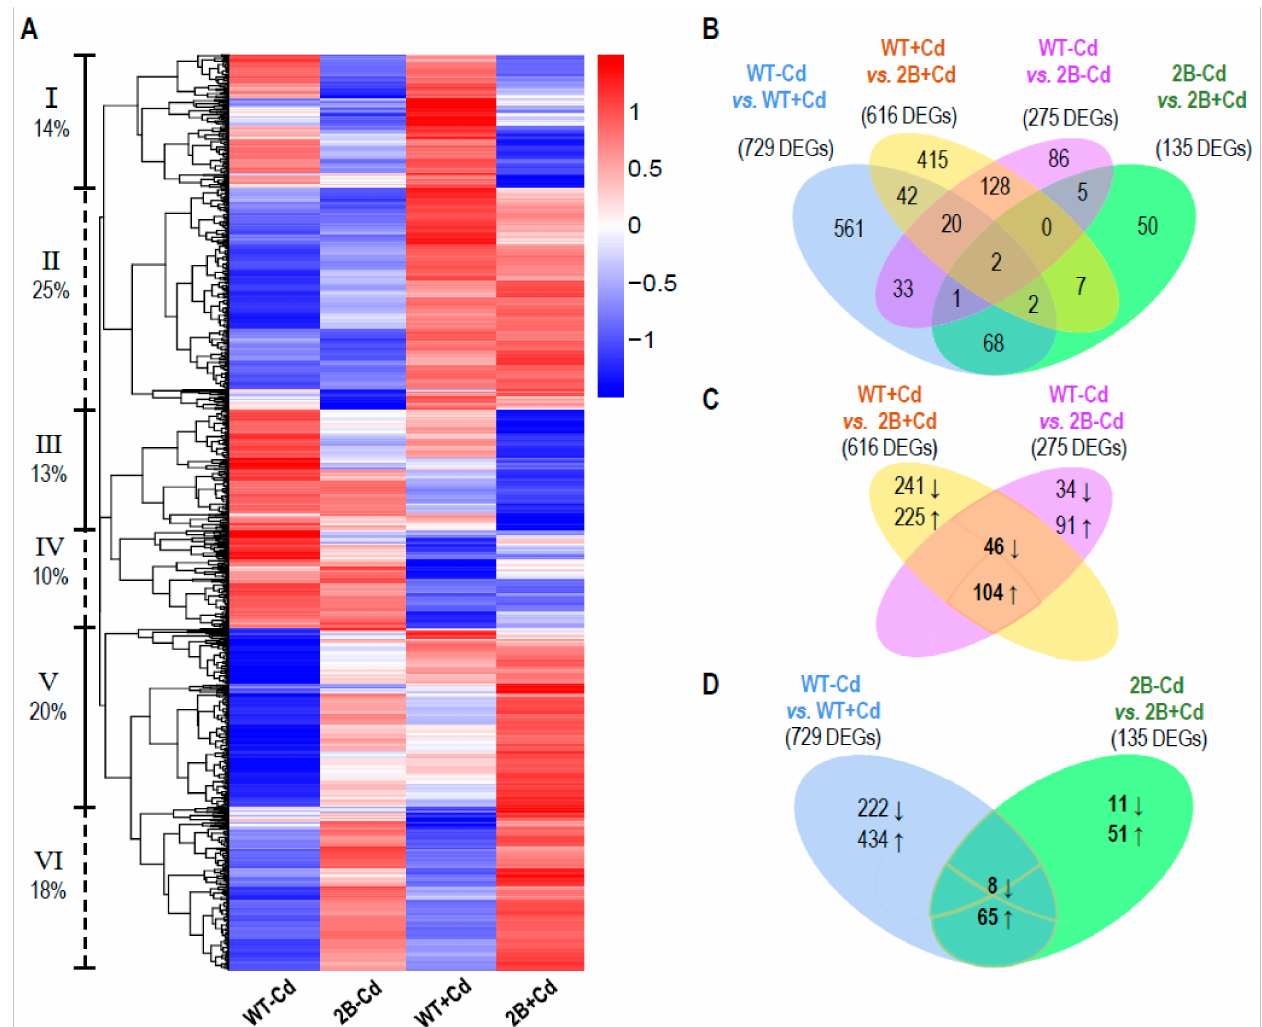
Figure 1. Expression profiling on rice altered by 2B expression and/or Cd treatment. ( A ) Heat map shows a one-dimensional hierarchical cluster analysis of 1420 DEGs (differentially expressed genes). Clusters I to VI produced according to the lg (FPKM + 1) values, % of total shown. ( B ) Venn diagram shows four comparison groups. ( C ) Comparison of WT + Cd vs. 2B + Cd and WT − Cd vs. 2B − Cd. ( D ) Comparison of WT − Cd vs. WT + Cd and 2B − Cd vs. 2B + Cd. Number of genes in each partition with up or down arrows indicates up- or down-regulation,